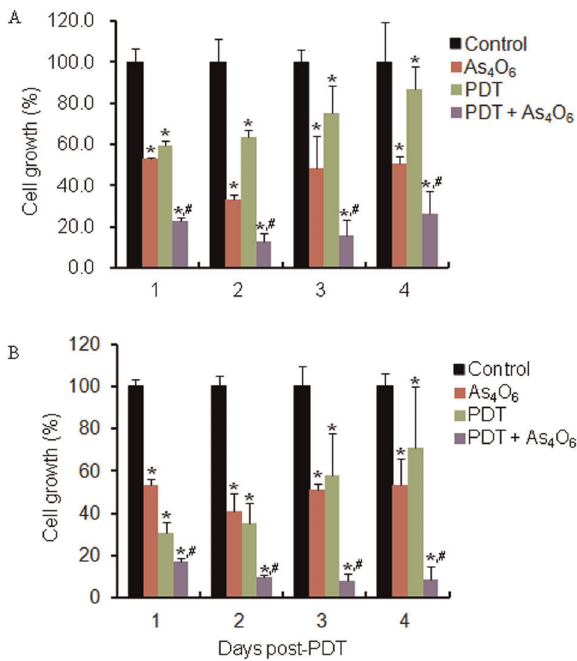
Figure 2 . In vitro cell growth inhibitory effects of As 4 O 6 plus Radachlorin/PDT on TC-1 cells. TC-1 cells were cultured with 3 uM of As 4 O 6 and (A) 0.15 ug/ml and (B) 0.2 ug/ml of Radachlorin/PDT, respectively. Cell viability was determined based on the MTT assay. Each bar represents a mean [ 6 SD (vertical line)] of three replicates (n=3). * and # : significantly different (P , 0.05) from the control and the PDT by the student’s t-test.